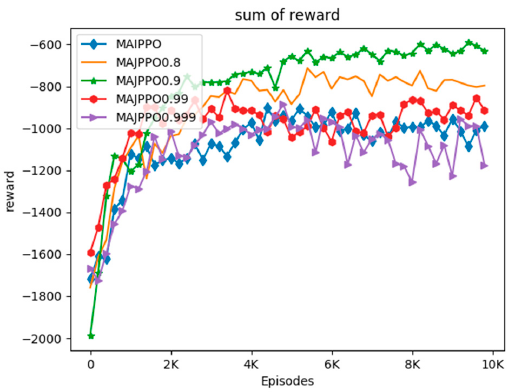
Figure 6. The learning curves of MAIPPO and MAJPPO for ξ = 0.8, 0.9, 0.99, and 0.999.